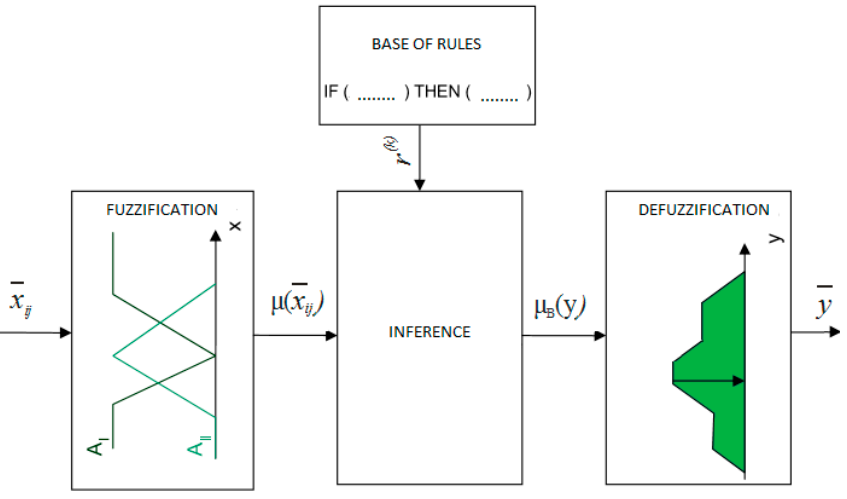
Figure 1. The structure of a fuzzy model of the service workshop selection process .